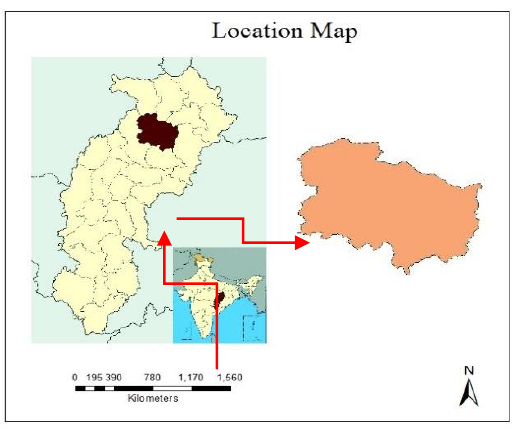
Figure 1. Korba district location map.